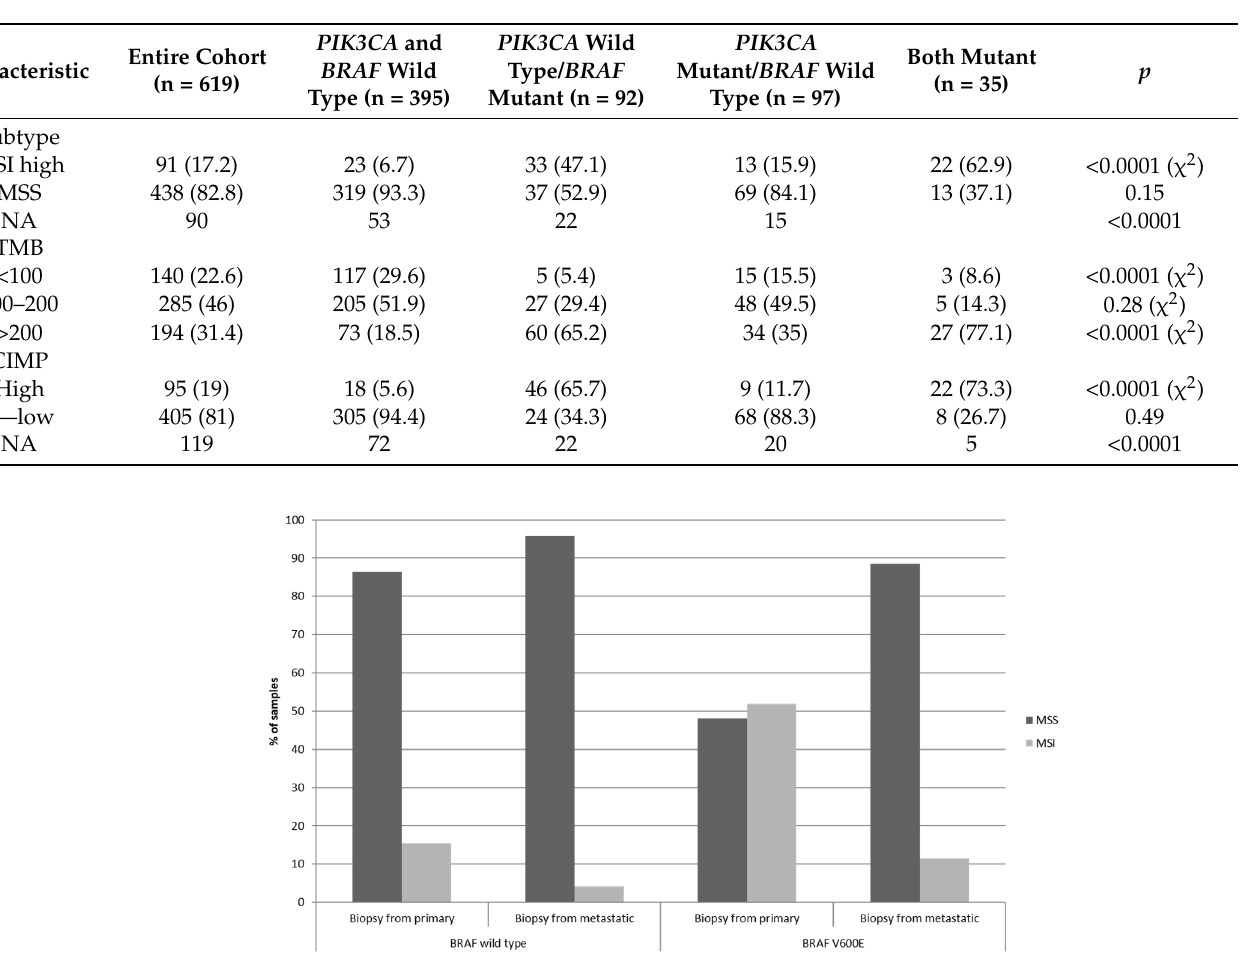
Table 4. MSI status, TMB, CIMP in the DFCI cohort. MSI: Microsatellite Instability; TMB: Tumor